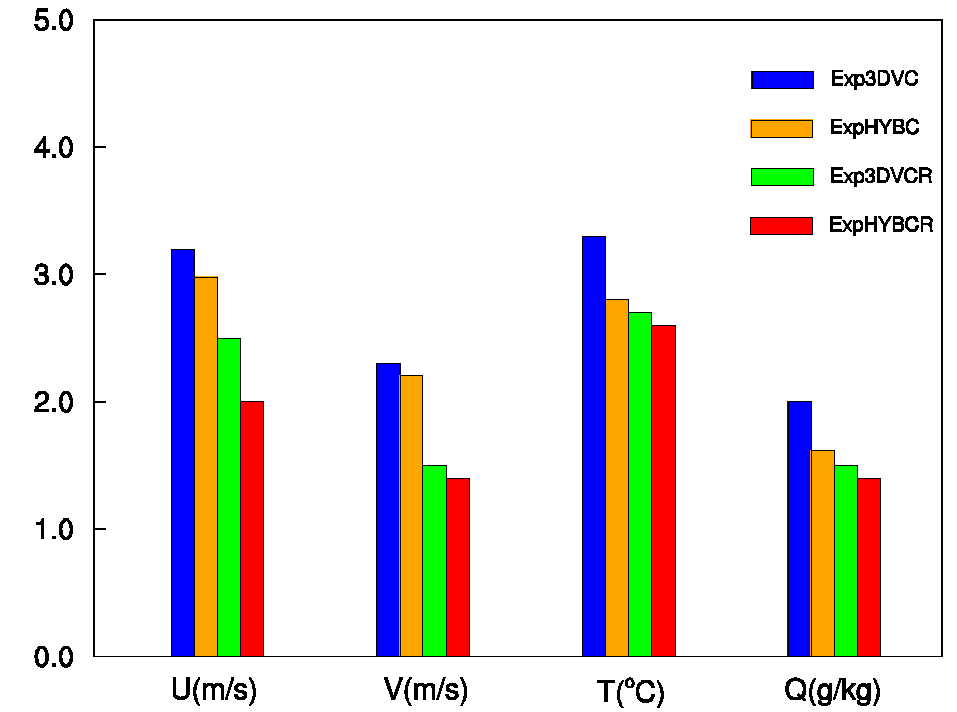
Figure 15. Average RMSE of forecast background against all the METAR stations in 3-km domain for u component (unit: m s −1 ), v component (unit: m s −1 ), T (unit: °C), and Q (unit: g kg −1 ), from Exp3DVC (blue bar), ExpHYBC (orange bar), Exp3DVCR (green bar) and ExpHYBCR (red bar).